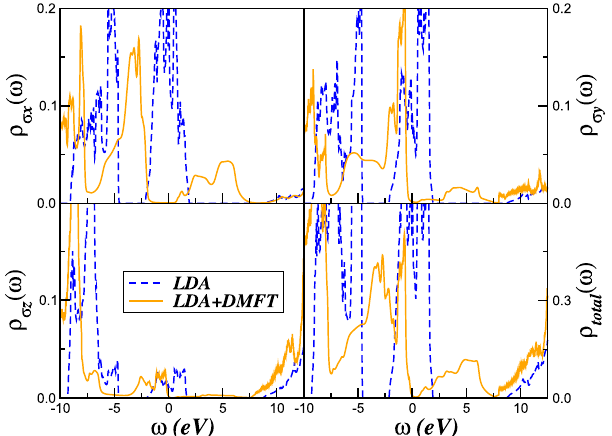
Figure 3. Comparison between the LDA and LDA + DMFT orbital-resolved and total density-of-states in the ε -phase of solid O 2 . LDA + DMFT results for the Mott insulating ε phase of oxygen were obtained using the intra- (inter-) orbital Coulomb repulsion, U = 11.6 eV ( U ′ = 10.7 eV) and the Hund’s rule interaction J H = 0.45 eV for the total band filling, n = 4. Large-scale transfer of spectral weight from low energy to high energies is visible in the correlated spectral functions of the p x and p y bands. Also clear is the destruction of the low-energy peak of the p z in